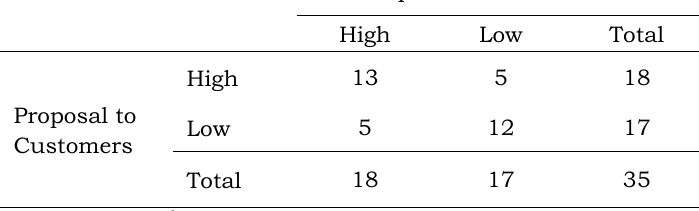
Proposal from Customers High Low Total